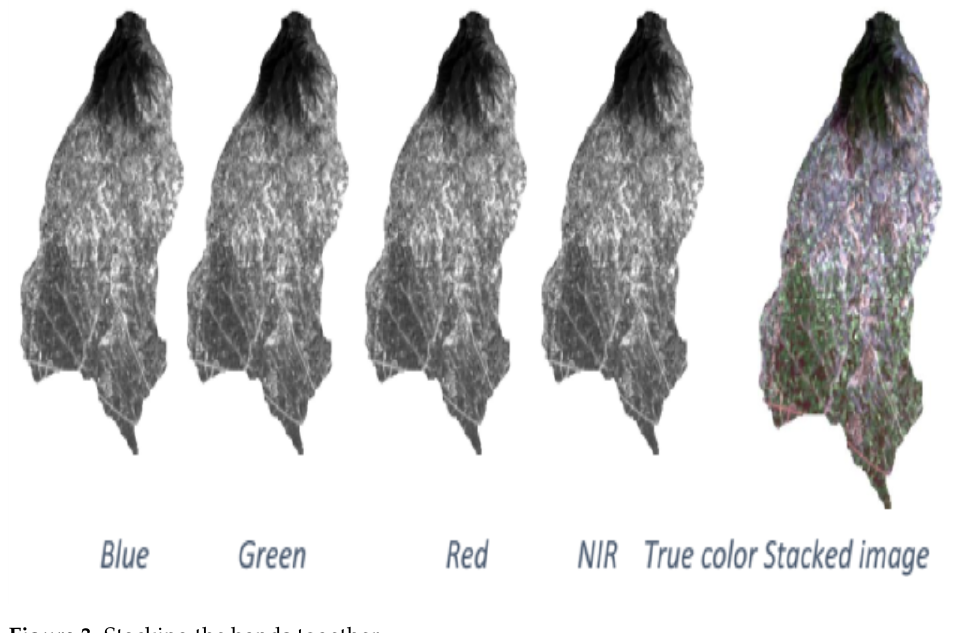
Figure 3. Stacking the bands together.